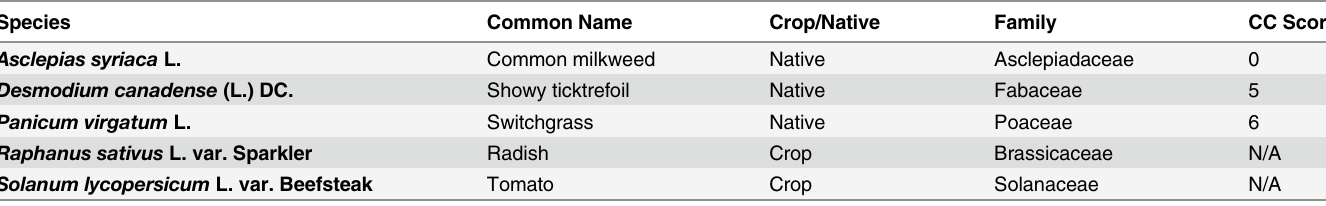
Table 1. Plant species tested in the rare earth element (REE) experiments. Species Common Name Crop/Native Family